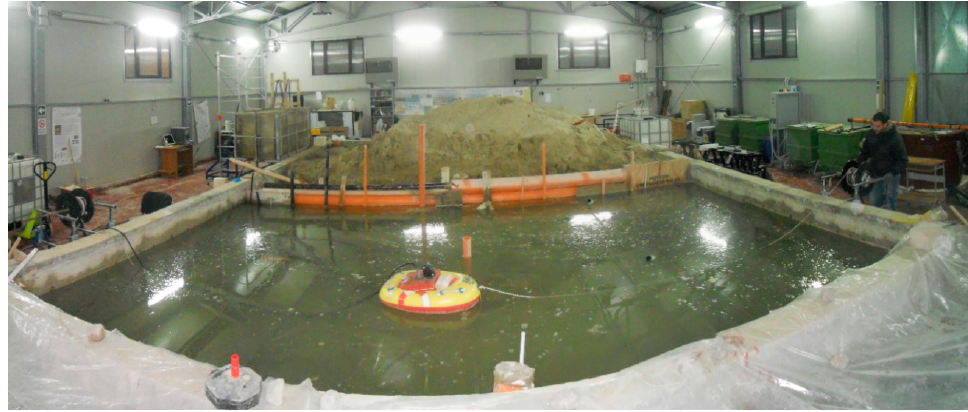
Figure 5. Photo of the investigated site with GPR system used for the acquisition without a survey wheel.